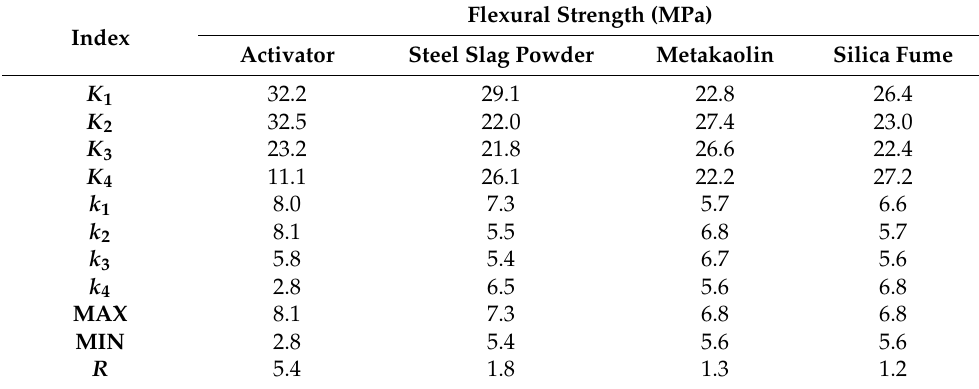
Table 8. Range analysis of flexural